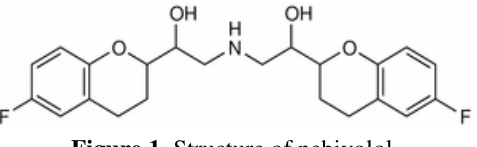
Figure 1 . Structure of